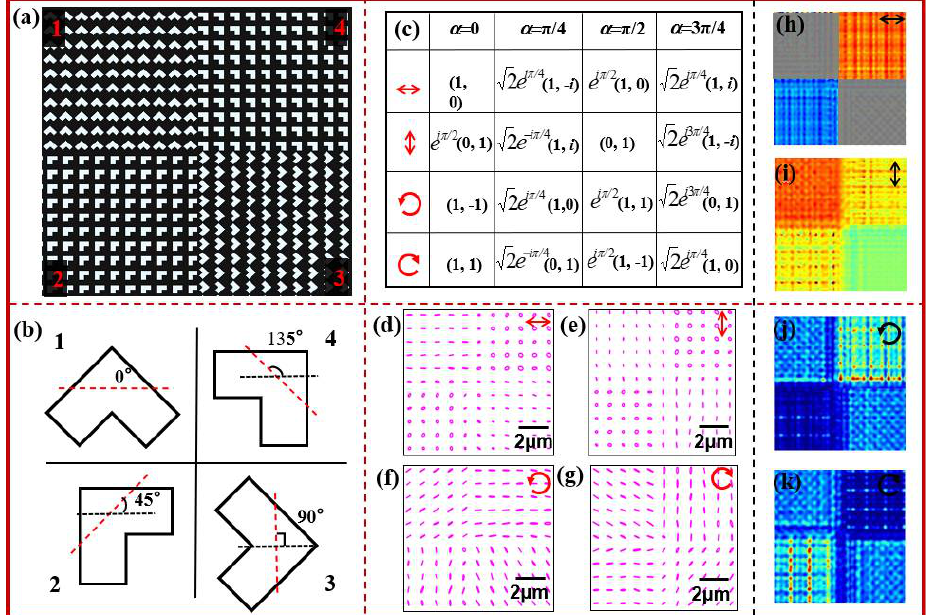
Figure 2. ( a , b ) Structures of metasurface integrated polarizer with four partitions where L-shaped nanoholes have the different orientation angles, ( c ) the transmission fields of nanohole with different orientation angle under different polarization light illumination, ( d – g ) the simulated polarization distributions of metasurface integrated polarizer, ( h , i ) are the simulated phase distributions for y components of transmission fields and ( j , k ) the simulated intensity distributions for y components of transmission fields, where the inserted arrows denote the illumination polarization states, and the scale bar denotes 2 µm.